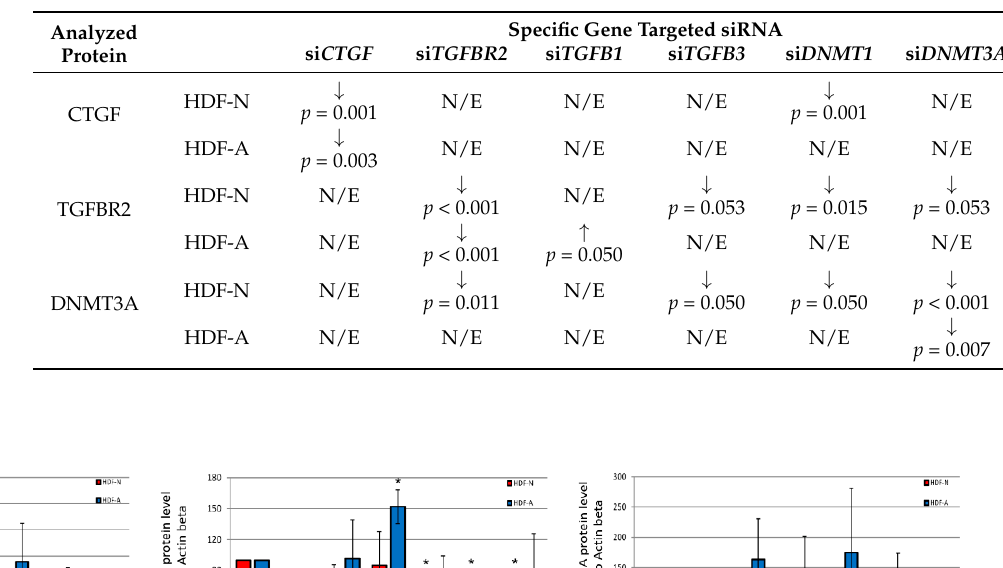
Table 1. Effects of the in vitro siRNA mediated knockdowns of CTGF , TGFBR2 , TGFB1 , TGFB3 , DNMT1 , and DNMT3A on CTGF, TGFBR2, and DNMT3A protein levels in neonatal (HDF-N), and adult (HDF-A) cell lines. Statistically significant increased and decreased protein levels are indicated by symbols ↑ , and ↓ , respectively; N/E, no effect.